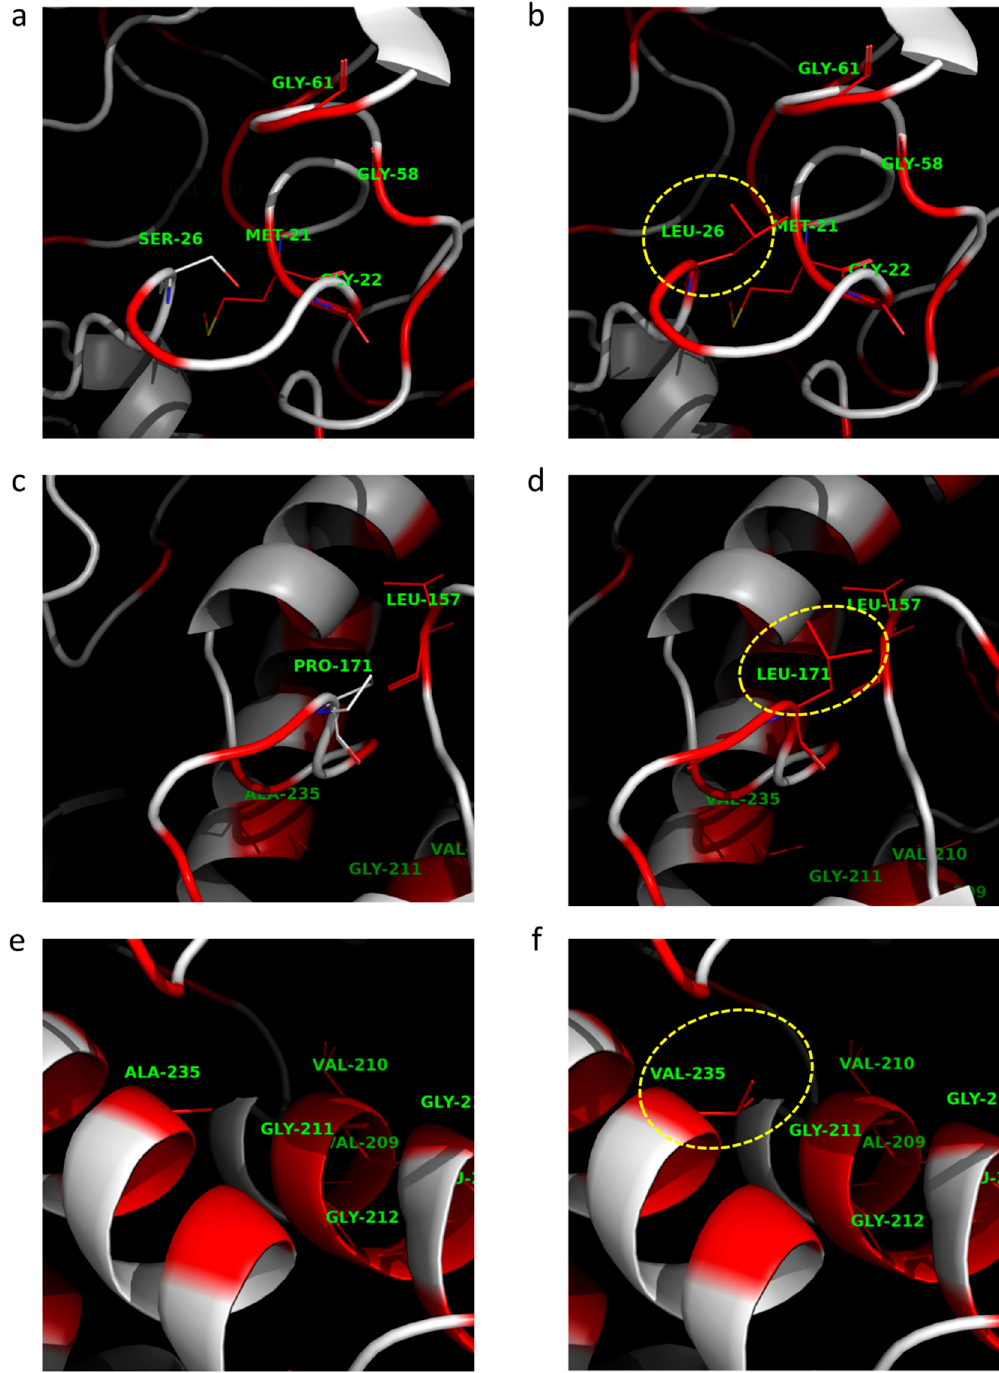
Figure 3. Ss β -Gly 3D structure in comparison with the H7 mutant model. Close-up of Ss β -Gly wild type structure (PDB ID: 1GOW) ( a , c , e ) and Ss β -Gly single mutations in the H7 mutant, S26L, P171L, and A235V in ( b , d , f ), respectively. The hydrophobic residues are indicated in red. The mutant residues are highlighted in yellow.